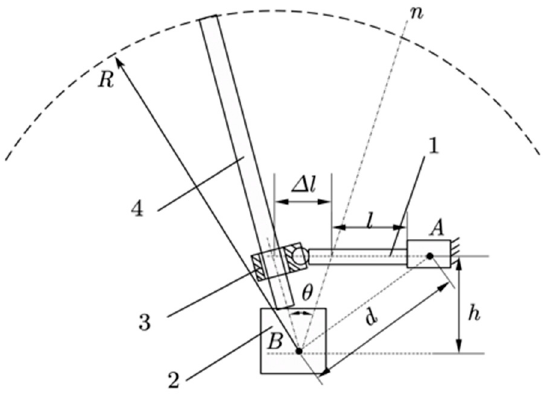
Figure 6. Schematic diagram of the electric actuator module: 1: stepping electric actuator, 2: hydraulic transmission, 3: kinematic pair, 4: gear lever.